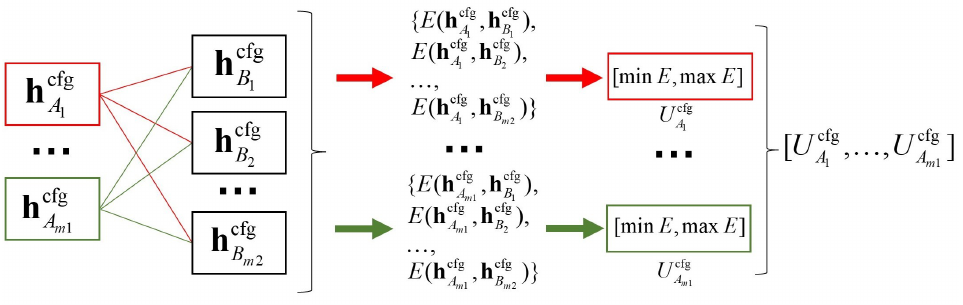
Figure 7. Schematic diagram of Formula